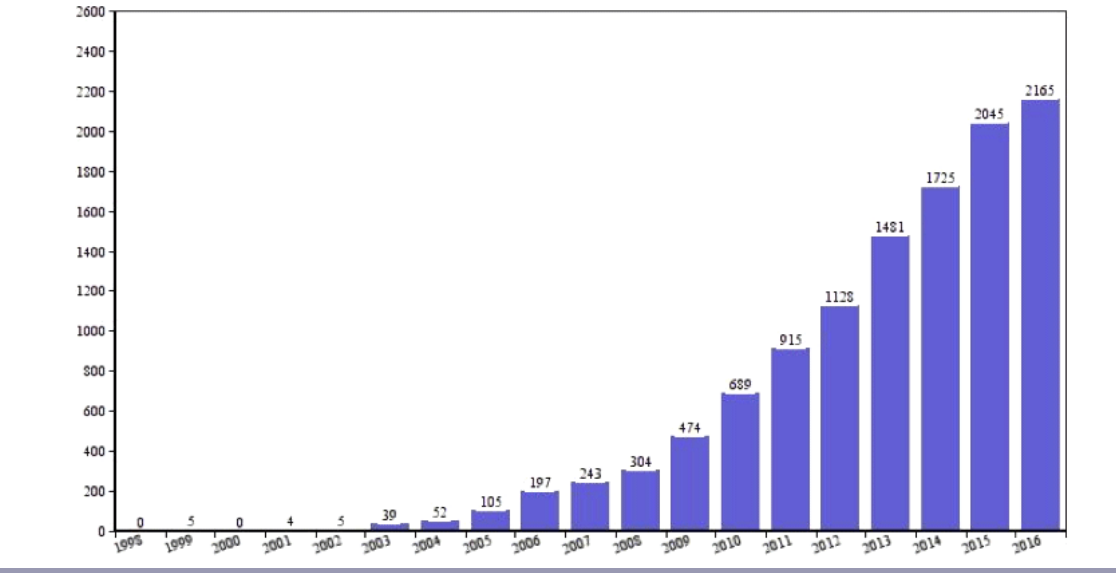
Fig. 2 . Publications related to social-ecological systems, covering the years 1998–2016. Source: Based